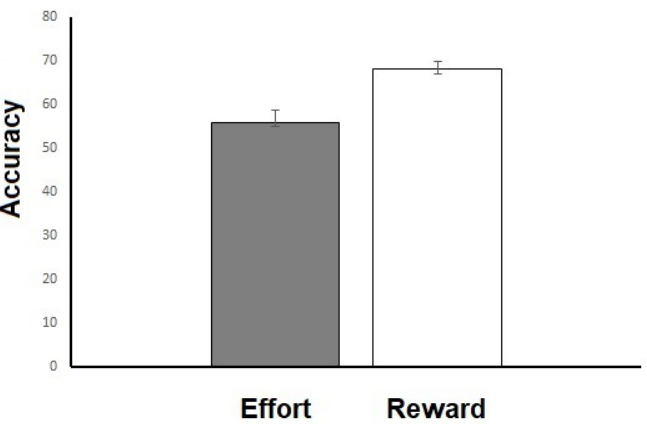
Figure 4. Shows the subjective ratings for liking, wanting and willingness to exert effort for each condition (choc: chocolate, money and puppies). * indicates significant